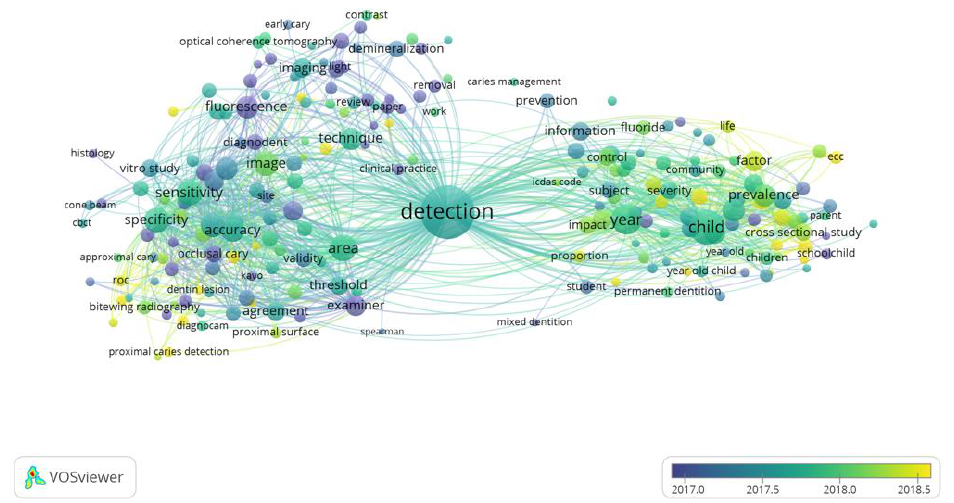
Figure 8. Map of terms appearing at least ten times. Bubble size indicates occurring frequency of terms as keywords in publications. The color of the bubble indicates the period in which terms are most used, choosing the time period where the greatest chromatic diversity is found.